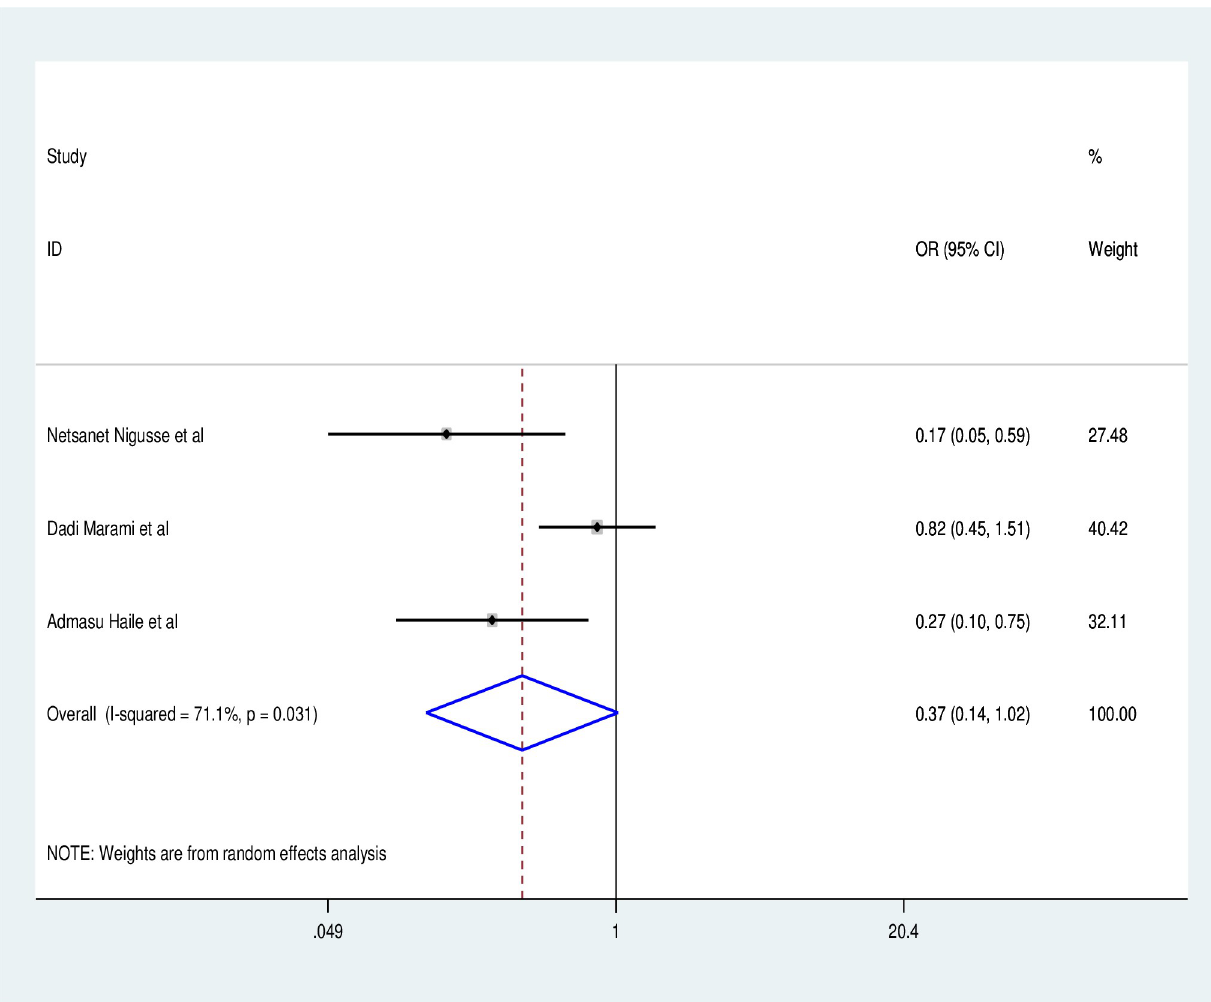
Fig 6. Factor analysis over sex. studies revealed that males living with HIV have a lower risk of UTI than females (OR:0.35, 95% CI: 0.14, 1.02), with statistically significant heterogeneity across studies (I 2 :71.1%, P = 0.03) (Fig 6). Rural residents are more likely to be exposed to UTI than urban residents (OR:1.41, 95% CI: 0.85, 2.34), with no statistically significant difference across studies (I 2 : 0.00, P = 0.37) (Fig 7). Those who have never had a catheterization have a lower risk of obtaining a UTI than those who have (OR: 0.35, 95% CI: 0.06, 1.86) with statistically significant heterogeneity across stud- ies (I 2 : 77.3%, P = 0.01) (Fig 8). Participants in the study who did not have a history of diabetes millitus had a lower risk of UTI than those who did (OR: 0.84, 95% CI:0.12, 0.597), with statis- tically significant heterogeneity across studies (I 2 :0.84, P = 0.001) (Fig 9). In addition to the foregoing, research participants with CD4 counts larger than 200 had a lower risk of UTI than those with CD4 counts less than 200 (OR:0.36, 95% CI: 0.06, 2.35) with statistically significant heterogeneity (I 2 :93.8%, P = 0.001) (Fig 10).